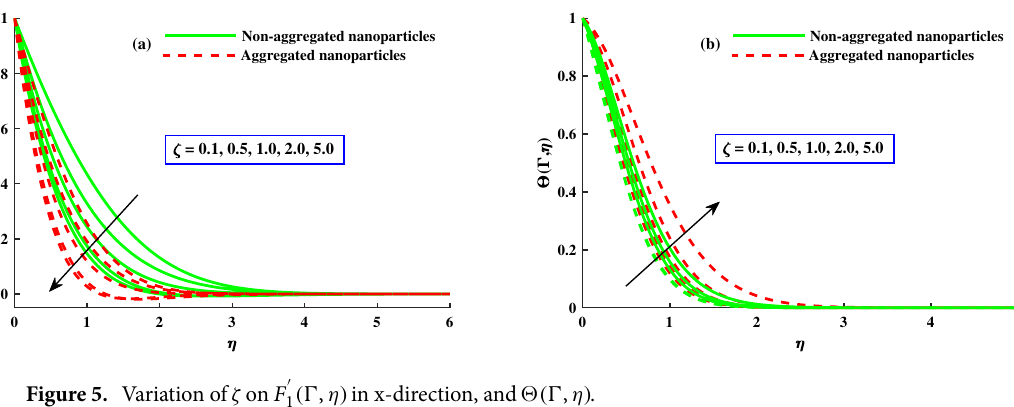
Figure 4. Variation of (cid:31) on F ′ 1 (Ŵ , η) in axial, and F ′ 2 (Ŵ , η) in transverse.